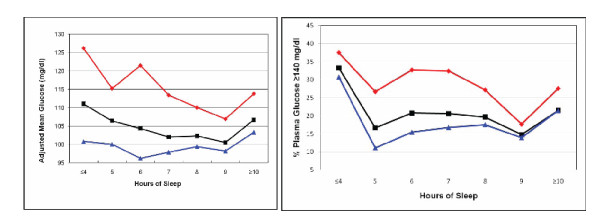
Maternal mean 1-hour plasma glucose concentrations after a 50-g oral glucose challenge. (a). Proportion (%) of women with 1-hour glucose concentrations ≥ 140 mg/dl (b). Values are plotted for the entire cohort (black), lean (body mass index < 25 kg/m2, blue) and overweight (body mass index ≥ 25 kg/m2, red) women, respectively.